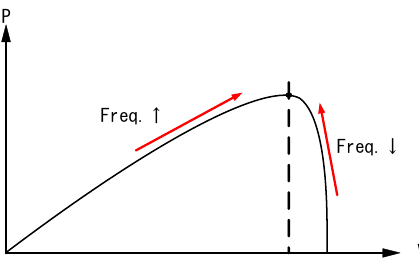
Figure 5. The P-V curve caused by changing switching frequency.